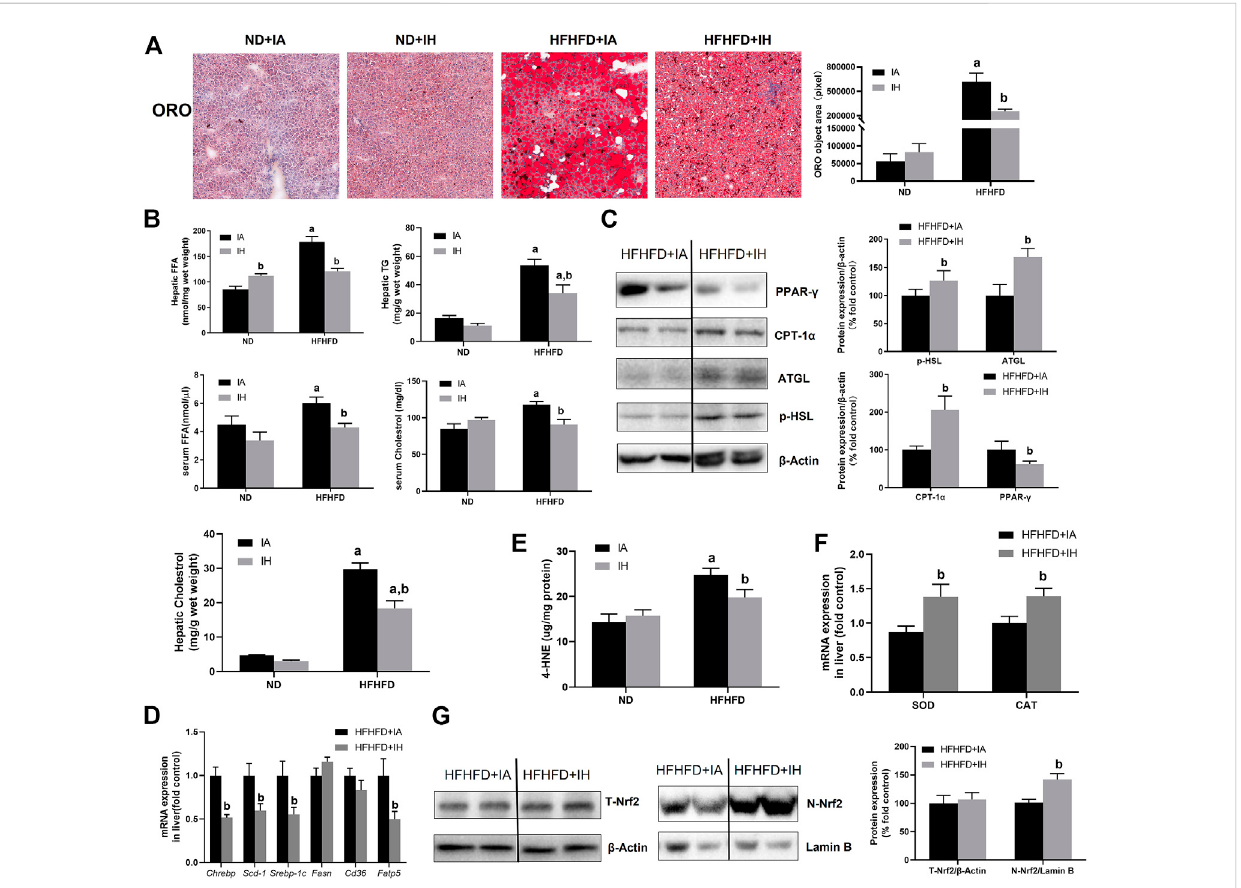
FIGURE 4 IH decreased lipid accumulation and increased antioxidant genes expression in the liver in HFHFD-fed mice. (A) Representative photomicrographs ofORO(neutrallipids,red)stainingat×200magni fi cationareshown. Rightpanel:OROstainingquanti fi cations. (B) Hepaticorserumcholesterol,TGand FFA content were measured as described in Material and Methods. (C) Representative Western blot analyses for lipid metabolism-associated proteins in liver extracts: p-HSL, ATGL, PPAR- γ and CPT-1 α . Densitometric analysis for these markers is shown in HFHFD + IA and HFHFD + IH. (D) Hepatic mRNA expression of lipogenesis markers Srebp-1c, Chrebp, Scd-1, Fasn, Fatp5 and Cd36 are shown. (E) Hepatic 4-HNE levels (ug/mg protein) were measured by ELISA kit in all groups, as described in Material and Methods. (F) mRNA expression of antioxidative enzyme SOD and CAT in the liver are shown. (G) Representative Western blot analyses for Nrf2 inliver extracts. Densitometric analysis for these markersis shown inHFHFD + IA and HFHFD + IH. a, p < 0.05 compared to ND control, b, p < 0.05 compared to absence of IH. Samples size per group n = 4 –